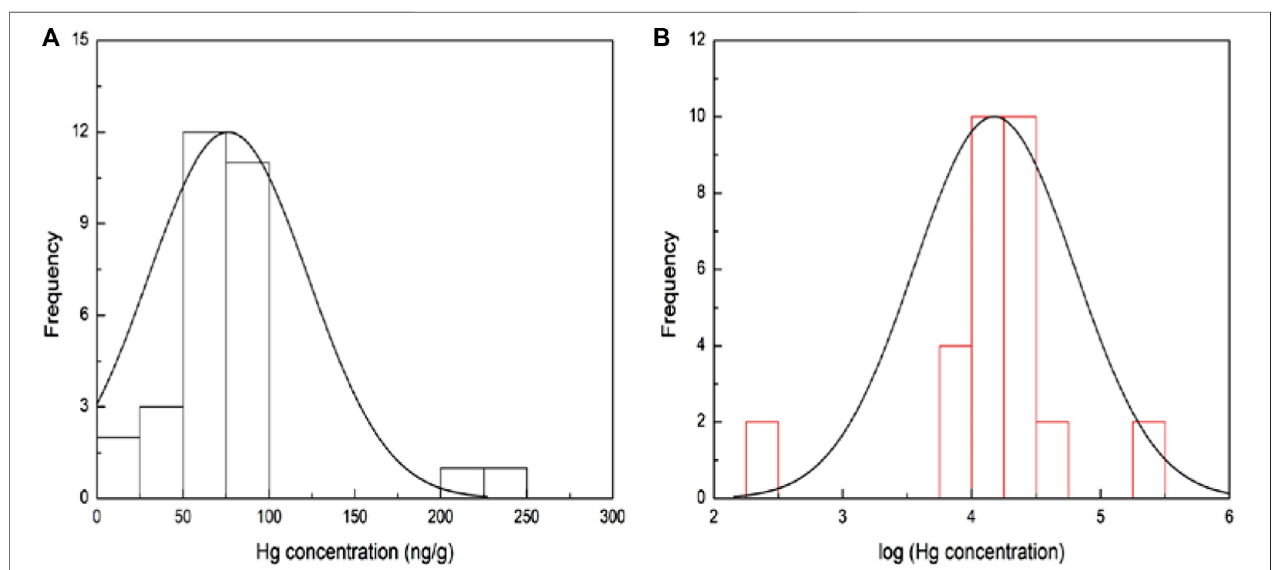
FIGURE 2 | Histogram of frequency of Hg concentrations in sediments of Taihu